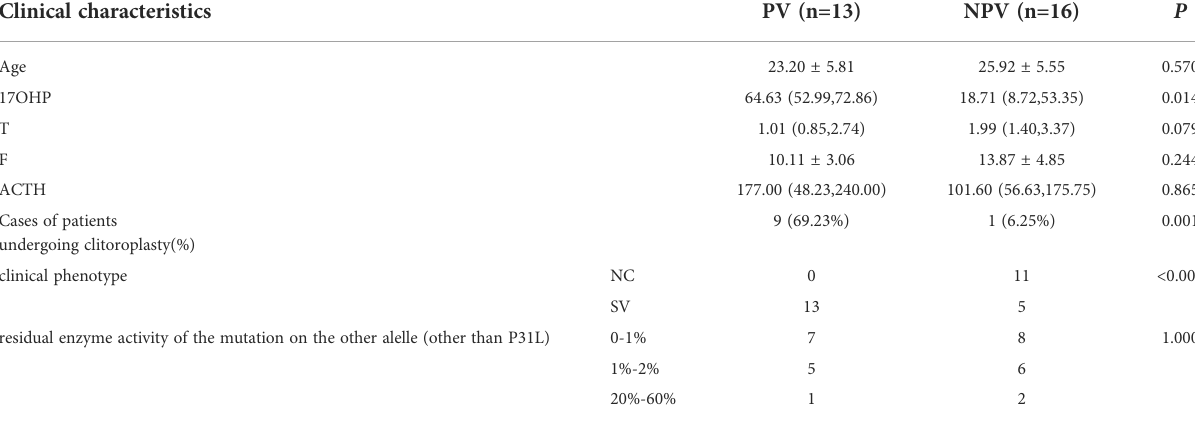
TABLE 3 Comparison of clinical characteristics of 21-OHD patients with both promoter variation and P31L variation versus P31L variation alone. Clinical